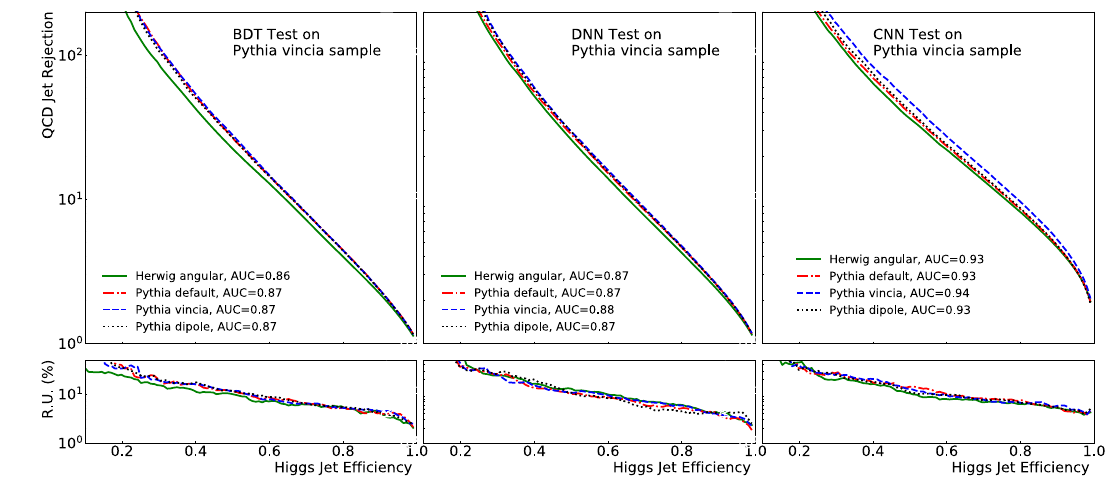
Fig. 9 The QCD rejection (inverse QCD efficiency) as a function of the Higgs jet efficiency for classifiers applied to Pythia VNICIA jet from four PSMC algorithms. The bottom panel shows the relative uncertainties